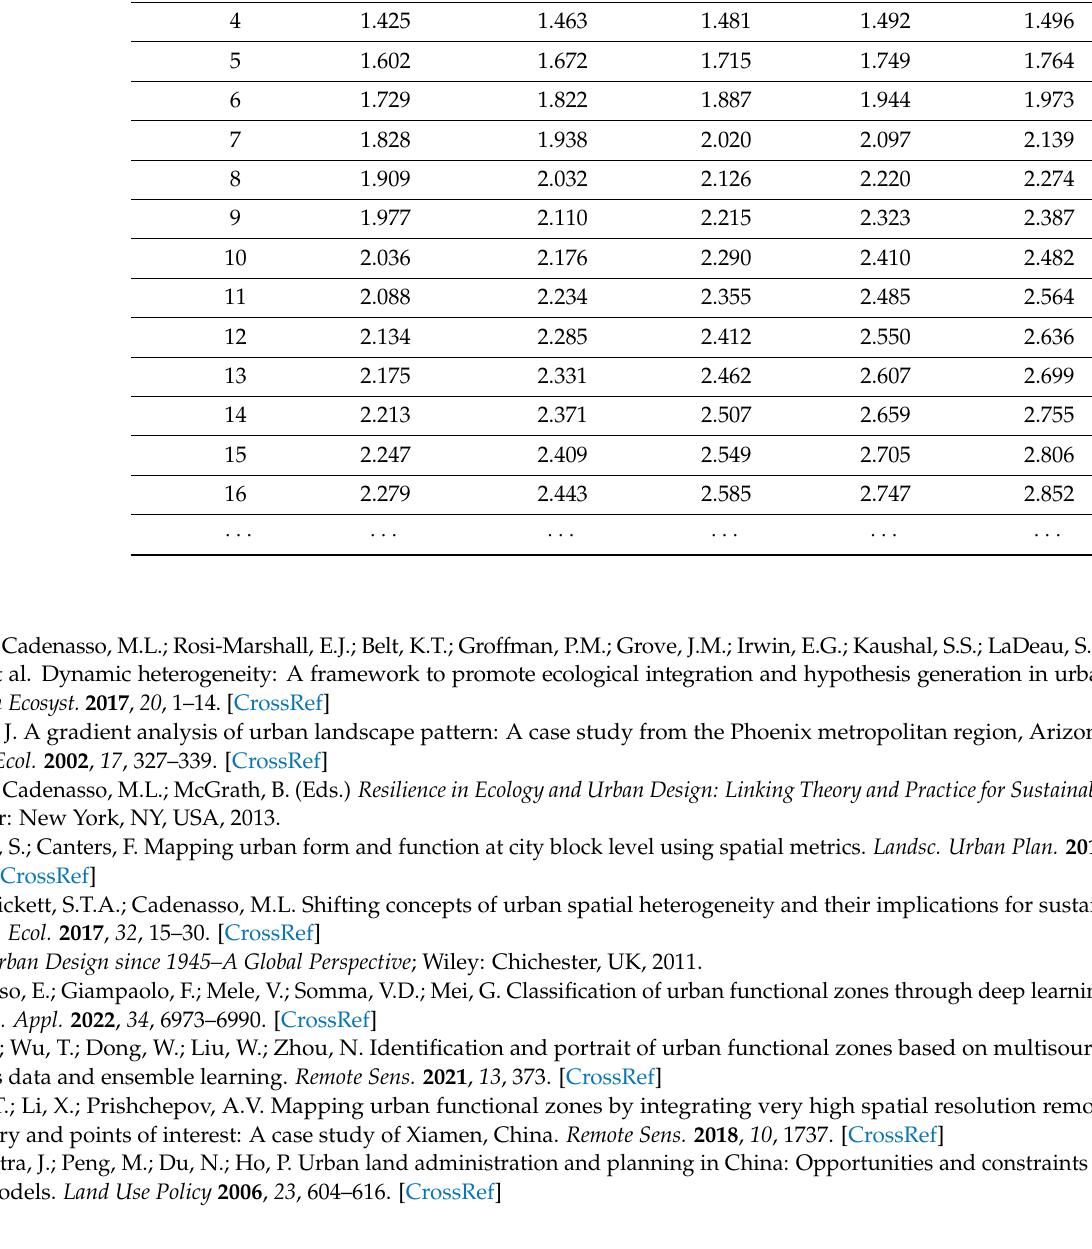
Table A1. Practical table for several critical values of the Grubbs criterion (G(n, ρ )).